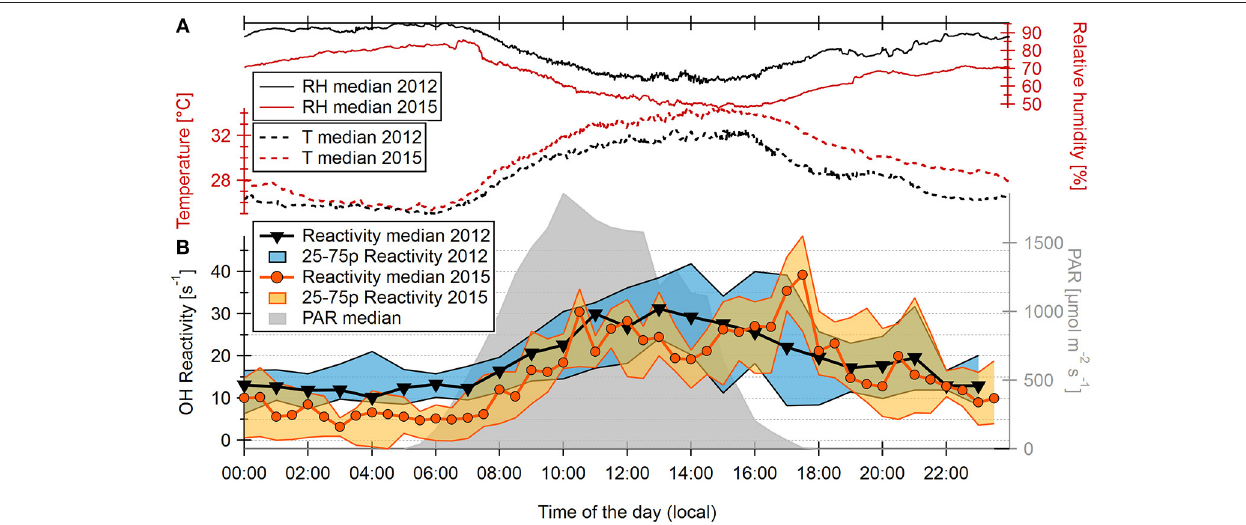
FIGURE 3 | (A) Median diel cycles of relative humidity and temperature for measurement periods in November 2012 and November 2015. (B) Diel medians of OH reactivity for Nov 2012 (hourly) and Nov 2015 (half-hourly), and photosynthetic active radiation (PAR) for Nov 2015 measured at 41m height above ground level. The shaded areas depict 25–75th percentiles of OH